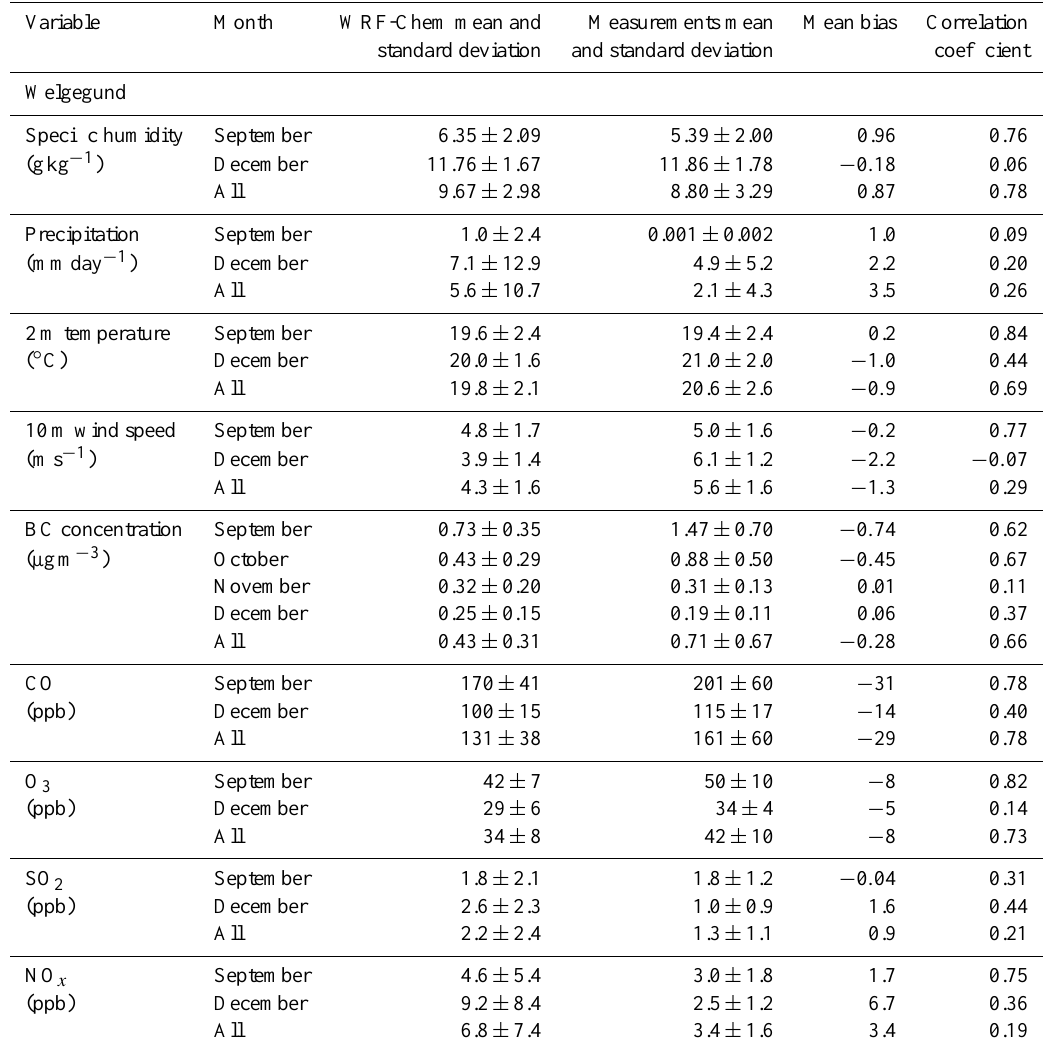
Table 2. Monthly mean of modeled and observed meteorology, BC and selected trace gases, mean bias of the WRF-Chem daily means with respect to observations and temporal correlation coefficient (Pearson) of daily means over 1month or the whole period September to December 2010 (all). Observational data are station measurements at Welgegund for all variables except for precipitation, which is obtained from the TRMM satellite